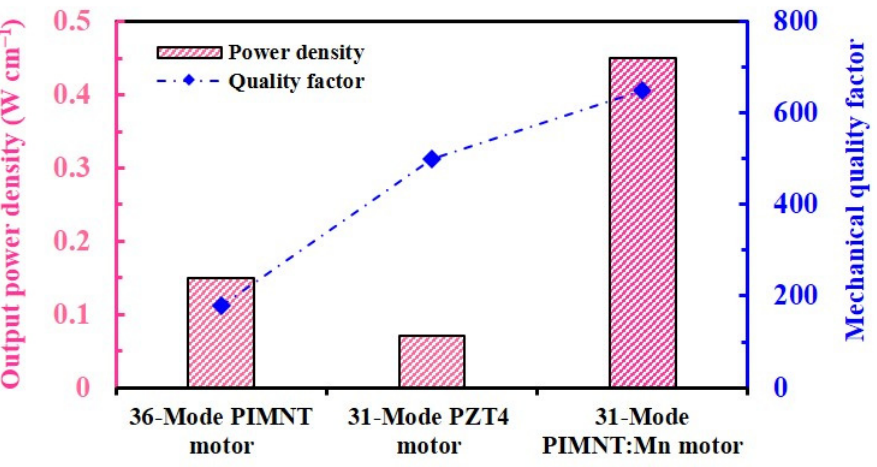
Figure 10. Output powers of 36-mode single crystal, 31-mode Mn-modified. single crystals and 31-mode PZT4 ceramic ultrasound motors [174,214,217].